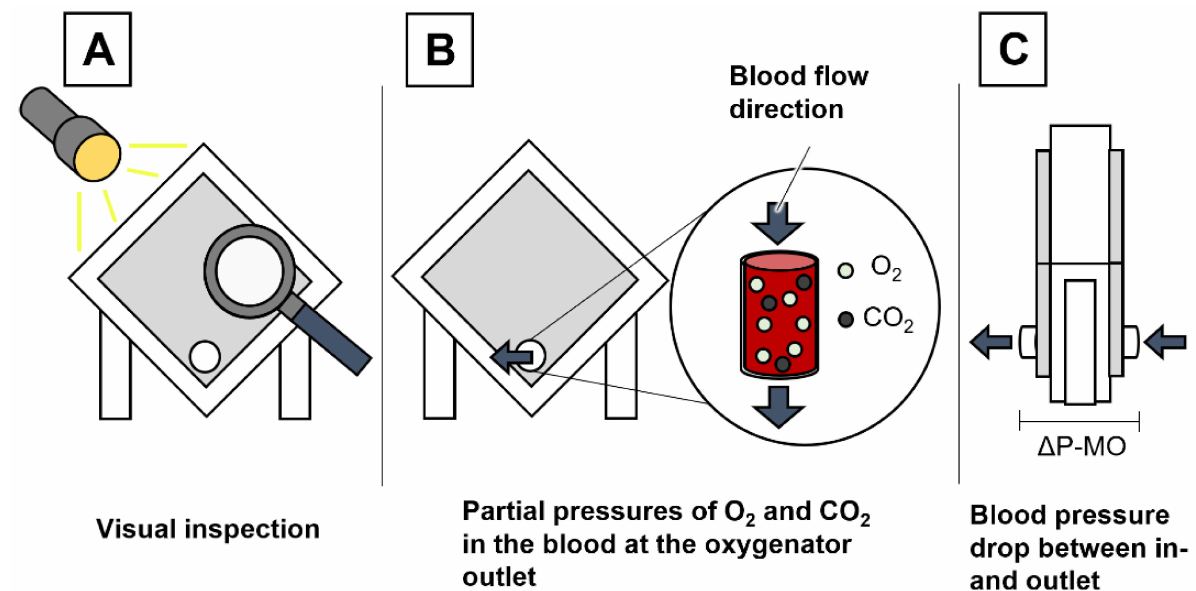
Figure 1. Overview of standard methods for clot detection ( A – C ) in a membrane oxygenator (MO) in the clinical daily routine; Visual inspection of the oxygenator ( A ), measuring the partial pressure of O 2 and CO 2 at the oxygenator outlet and blood pressure drop detection ( C ) as the ultimate emergency indicator for MO